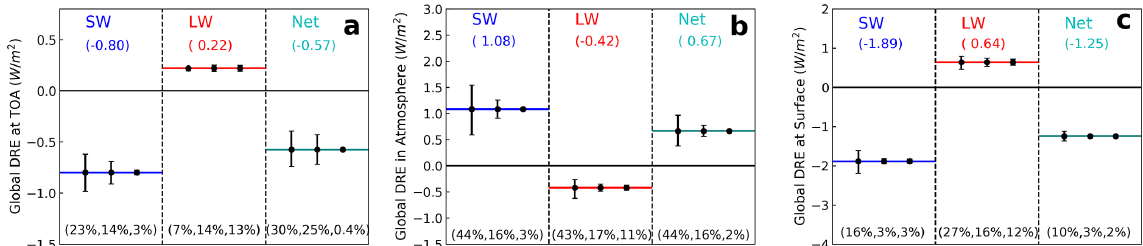
Figure 12. Comparison of uncertainty induced by dust RI, PSD and shape in DRE SW , DRE LW and DRE NET at TOA (a) , in the atmosphere (b) and surface (c) . The horizontal lines in each plot represent global mean DRE SW (blue line in the left column), DRE LW (red line in the middle column) and DRE NET (green line in the right column) averaged over two dust PSDs (i.e., Kok2017-PSD and Campaign-PSD) based on MeanRI-Spheroid dust model. The three error bars in each column represent DRE uncertainty induced by dust RI (left), dust PSD (middle) and dust shape (right). Accordingly, the percentage values on the bottom represent the percentage uncertainty induced by dust RI, PSD and shape,